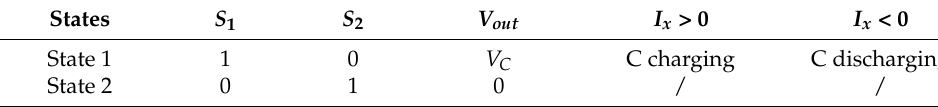
Figure 2. Half-bridge SM: ( a ) connected state, ( b ) bypassed state, and ( c ) blocking state. Table 1. HB-SM switching states table.